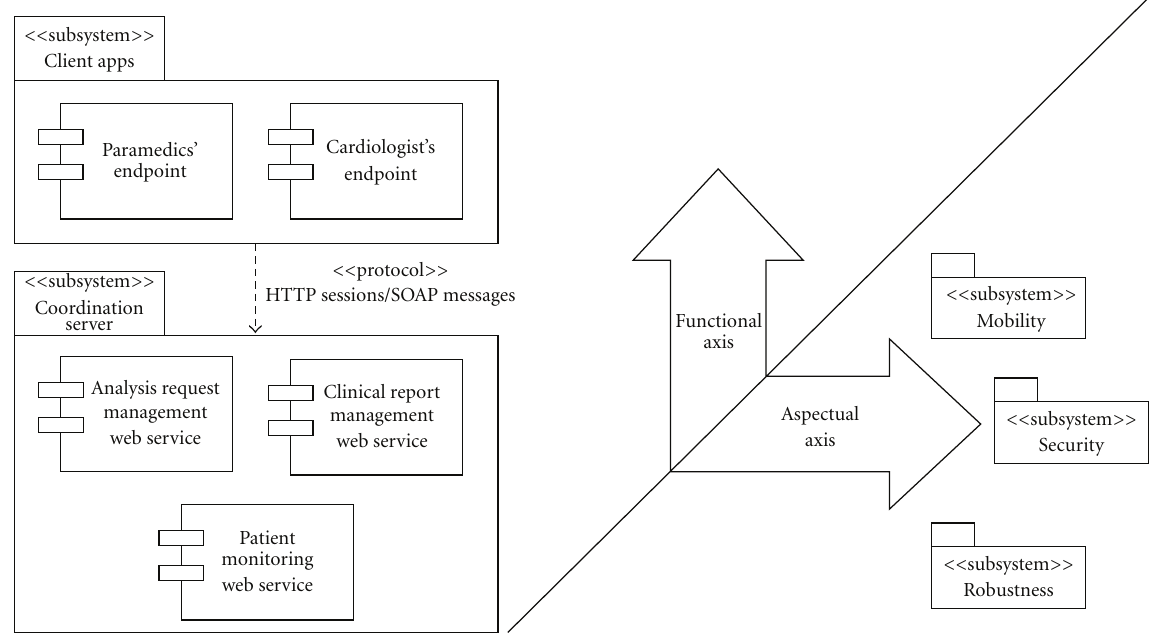
Figure 2: Functional and aspectual axes in the AToMS system.